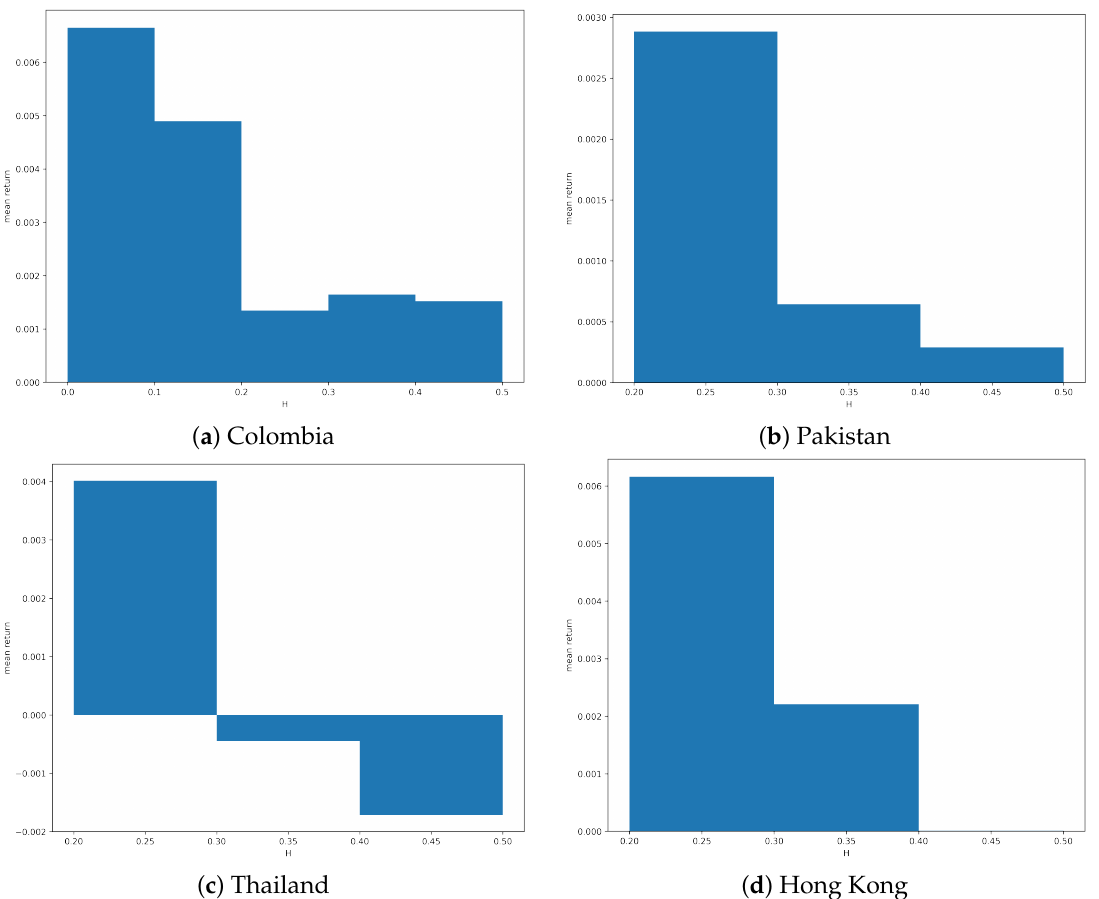
Figure 6. Comparison between the value of H and the mean return between countries for the period